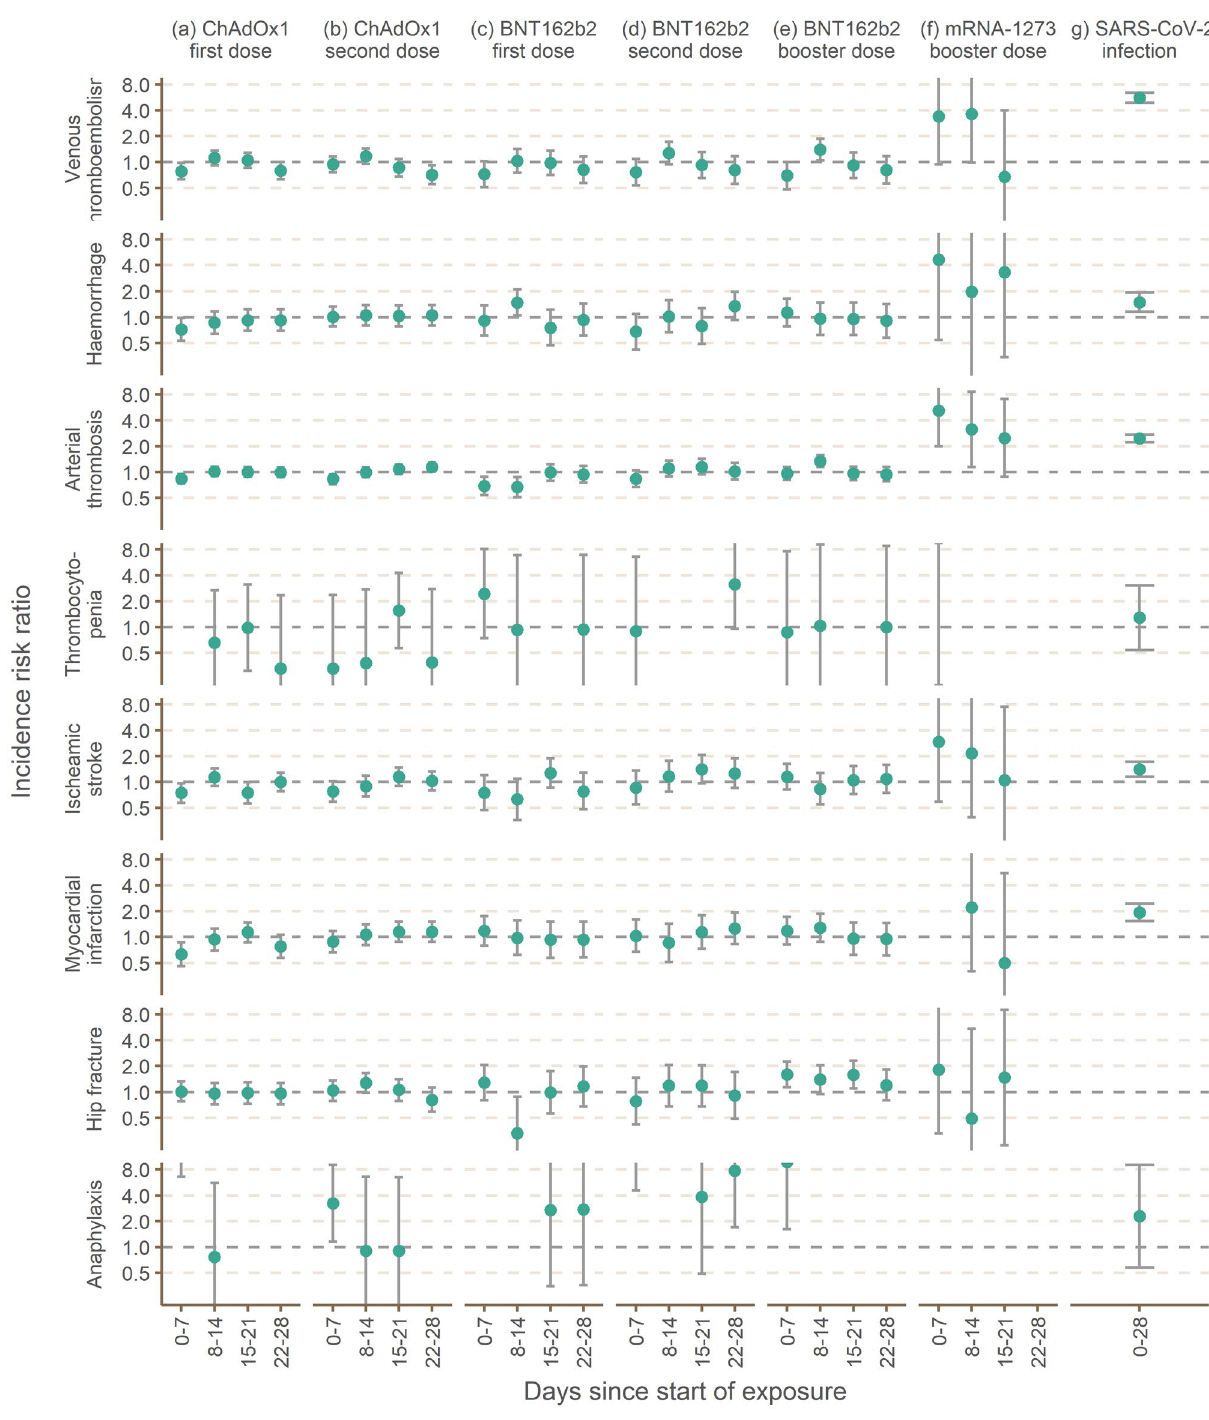
Figure 3. Incidence rate ratios (95% confidence intervals) for primary and secondary outcomes in 0–28 and 29 or more days after the first and second doses of ChAdOx1 (and BNF162b2 vaccines, and